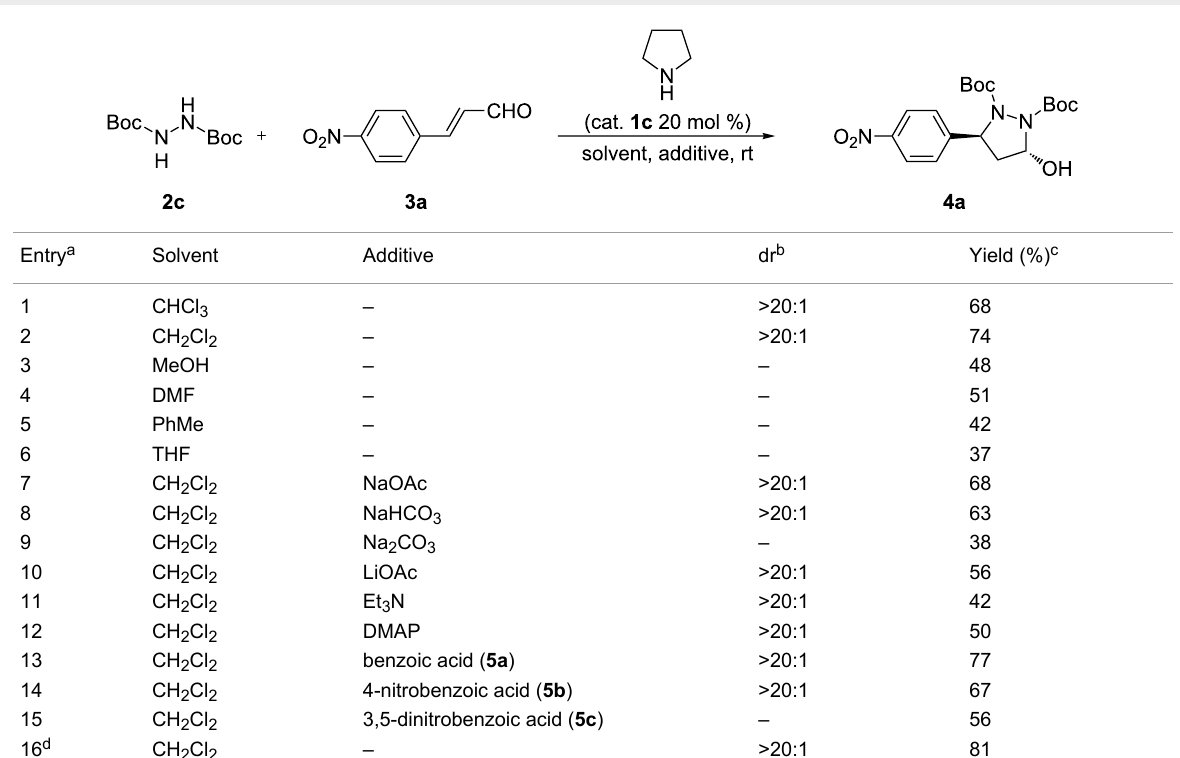
Table 1: Secondary amine catalyzed cascade aza-Michael/hemiacetal